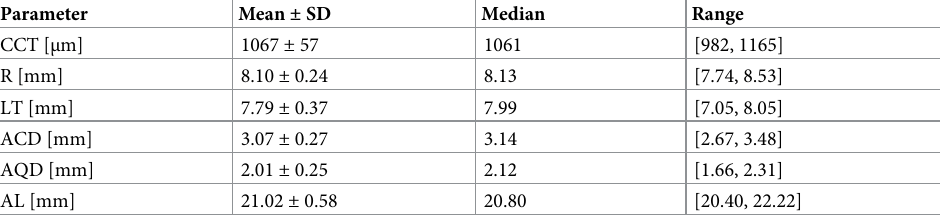
Central corneal thickness (CCT), corneal radius (R), lens thickness (LT), anterior chamber depth (ACD), aqueous